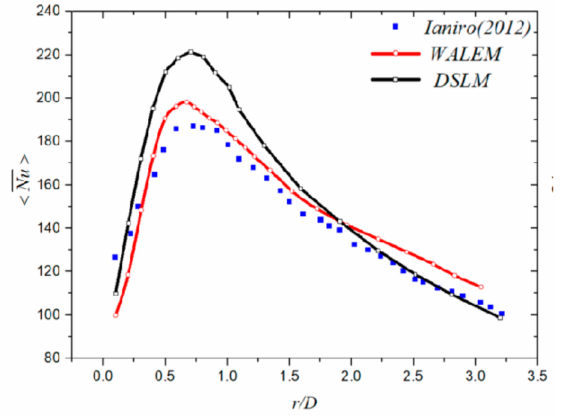
Figure 4. Radial distribution of Nu at the flat target